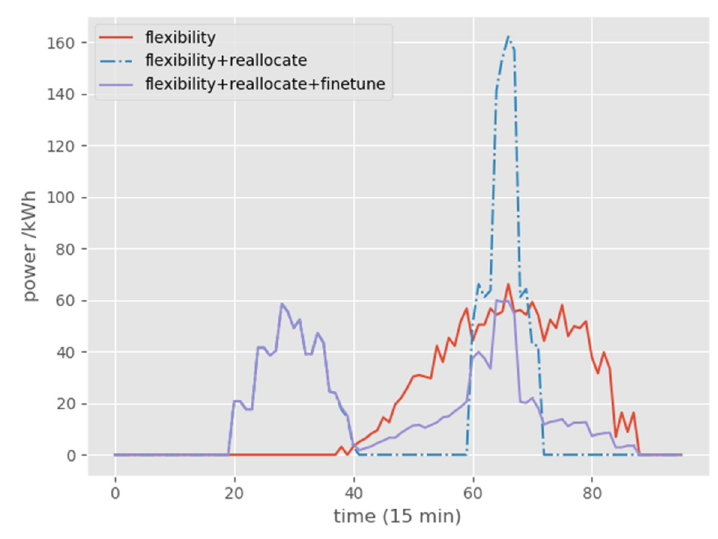
Figure 8. Total power distribution of